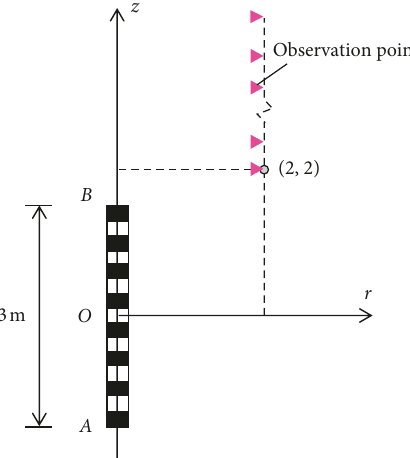
Figure 9: Illustration of the observation points along the axial direction of the cylindrical